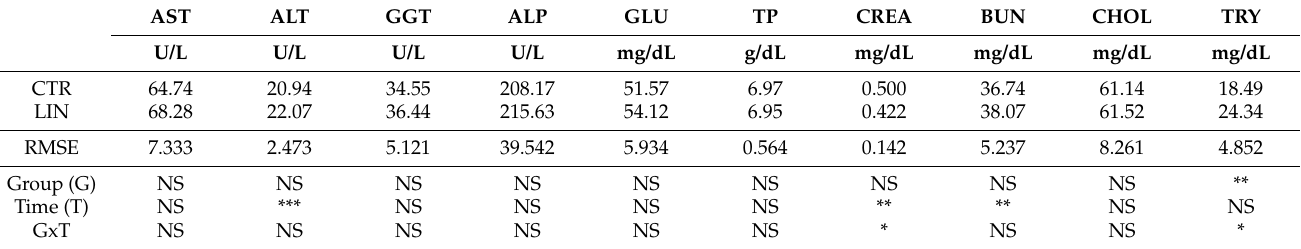
Table 5. Goats’ serum biochemistry (mean value) of control (CTR) and linseed supplementation (LIN) groups.